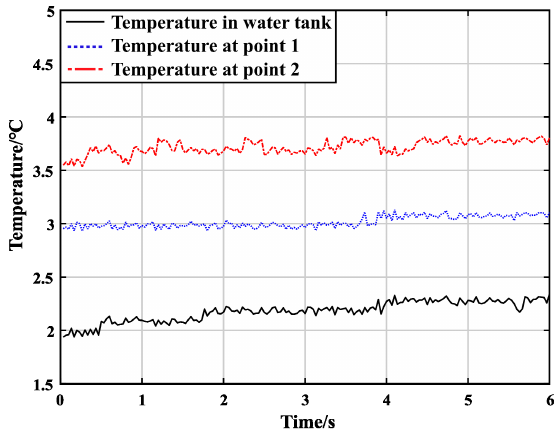
Figure 16. The temperature curve of the system.